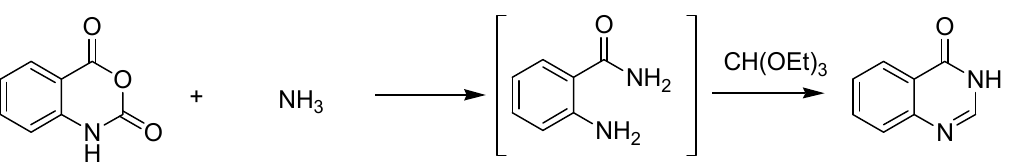
Figure 5. Synthesis of 2-methyl-5-nitroquinazolin-4(3H)-one.